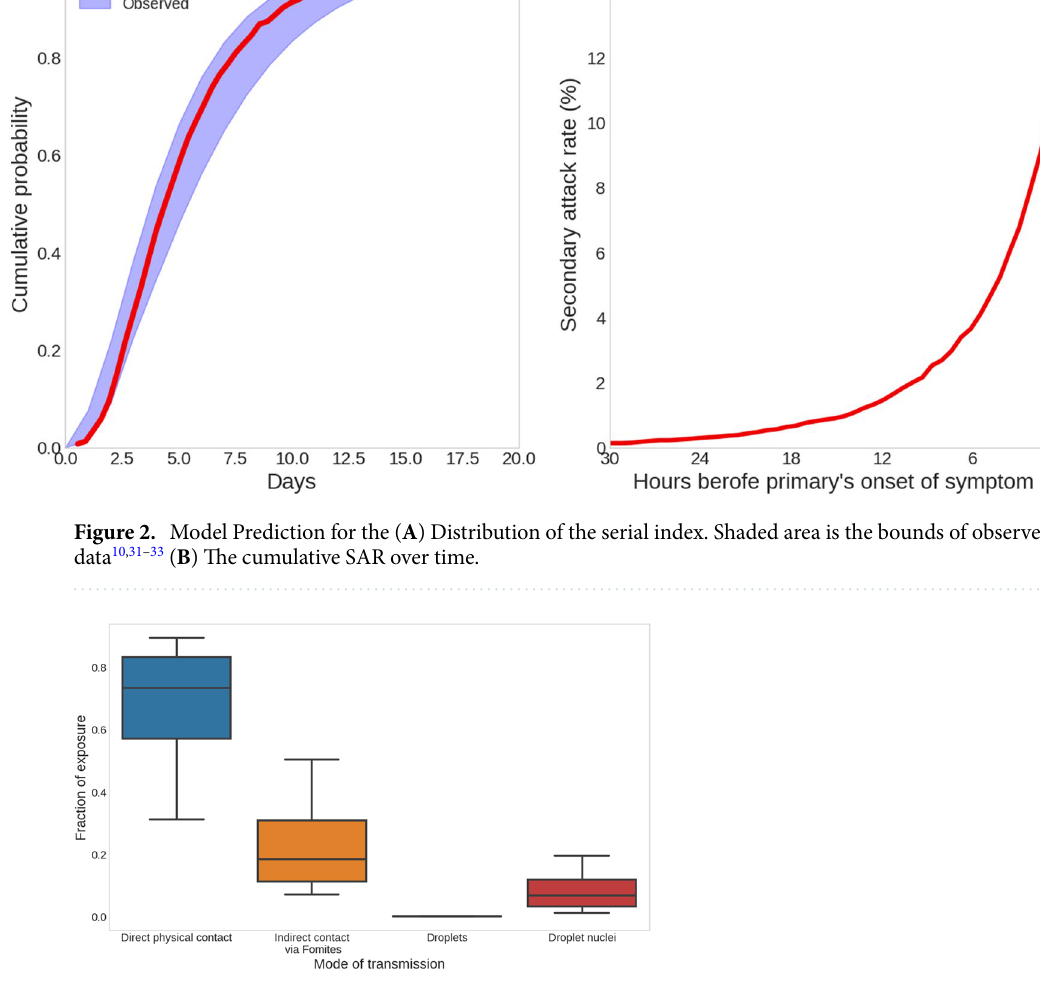
Figure 3. The contribution of the different modes of transmission to overall exposure. Box represents the inter- quartile range (IQR). The whiskers represent the 10th and 90th